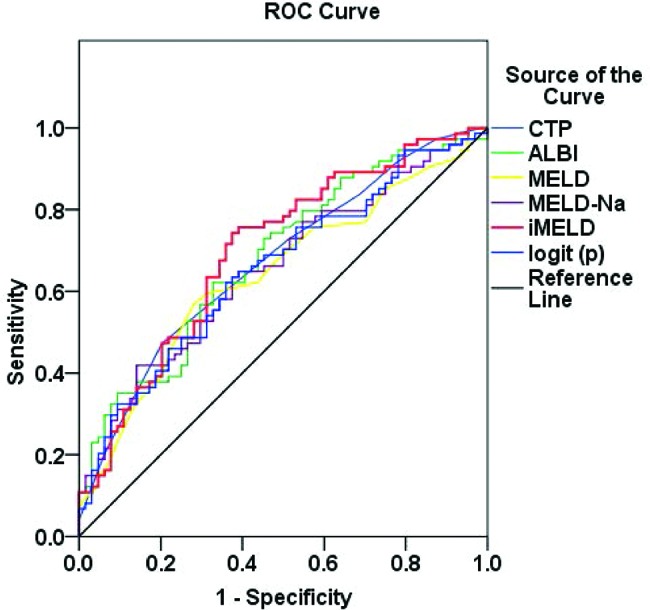
ROC curves for CTP, MELD, MELD-Na, iMELD, ALBI score and logit (p) curve.